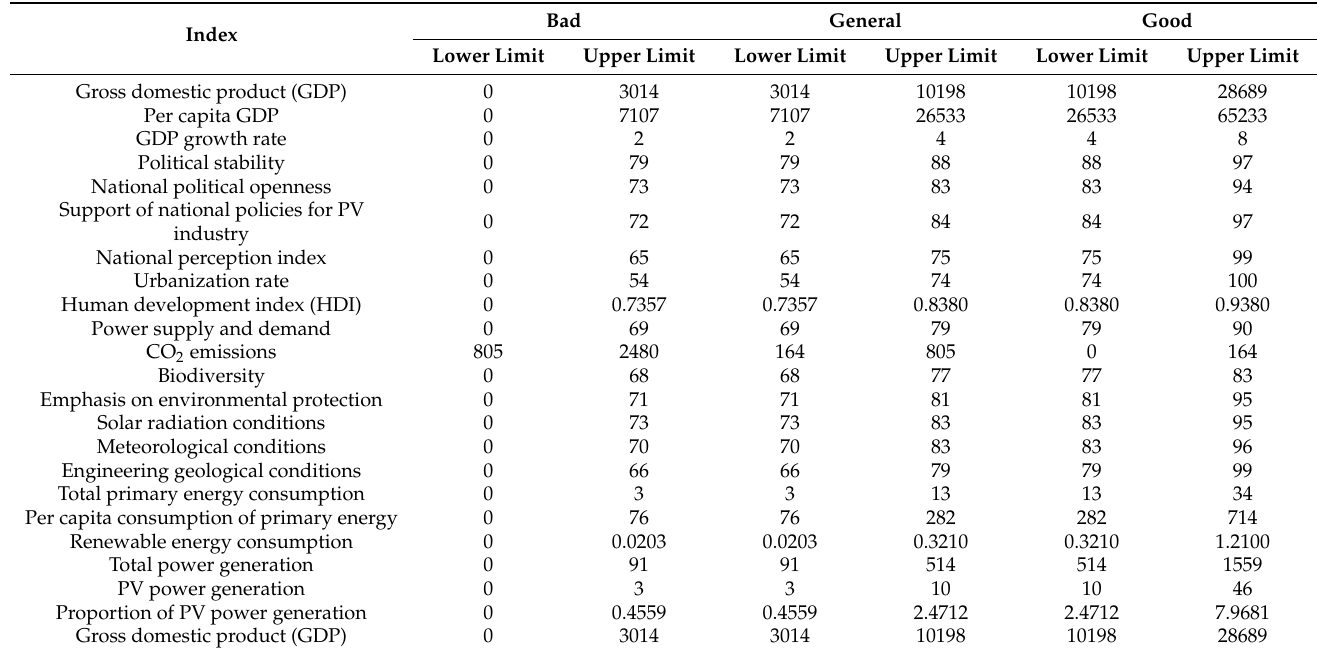
Table 4. Positive and negative solutions.